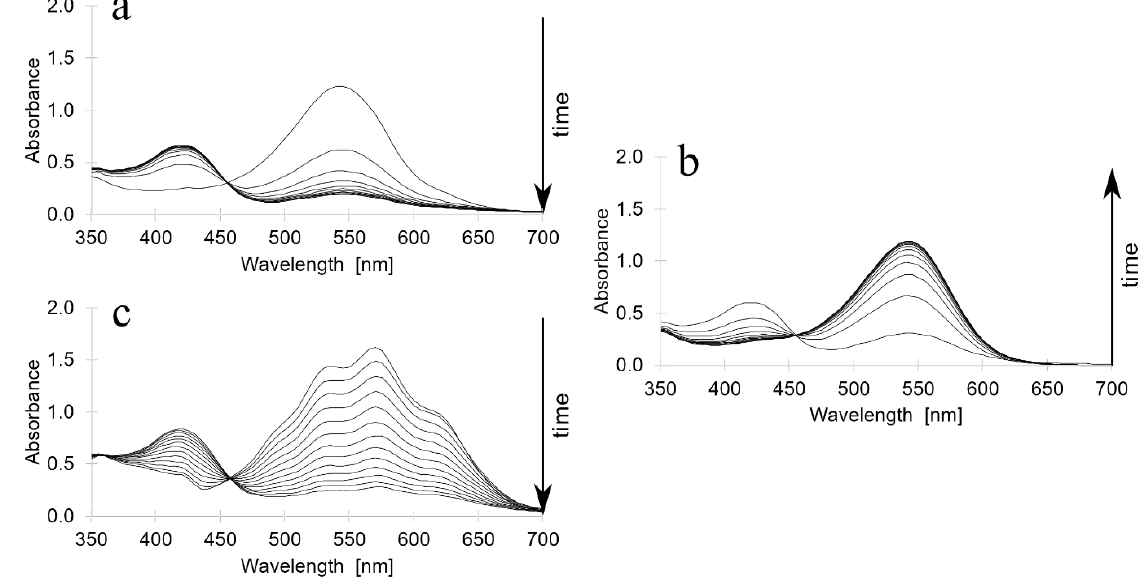
Figure 2. Visible absorption spectra of samples of Sphagnorubin C ( 1 ) recorded at 2-h intervals for 24 h, with different pre-treatments of the samples (see section 4.2). ( a ) Sample D dissolved in pure DMSO: The spectra show the decrease of the flavylium cation form ( λ max at 540 nm) and the increase of the trans -chalcone form ( λ max at 420 nm) with time. Equilibration is obtained after circa 14 h. ( b ) Sample E (Sample D after 24 h acidified with 5% TFA): The spectra show the increase of the flavylium cation form and the decrease of the trans -chalcone form with time. ( c ) Sample F 3 (see section 4.2) dissolved in pure d -DMSO: The spectra show the decrease of the quinoidal forms and the increase of the trans -chalcone form with time. F 3 has initially a dark blue/purple colour typical for quinoidal forms. 5% TFA was also added to sample F 3 after 24 h, which gave virtually identical results to those described for sample E, Note the isosbestic point at 455 nm in all the three spectra series. The spectra were recorded at room temperature.